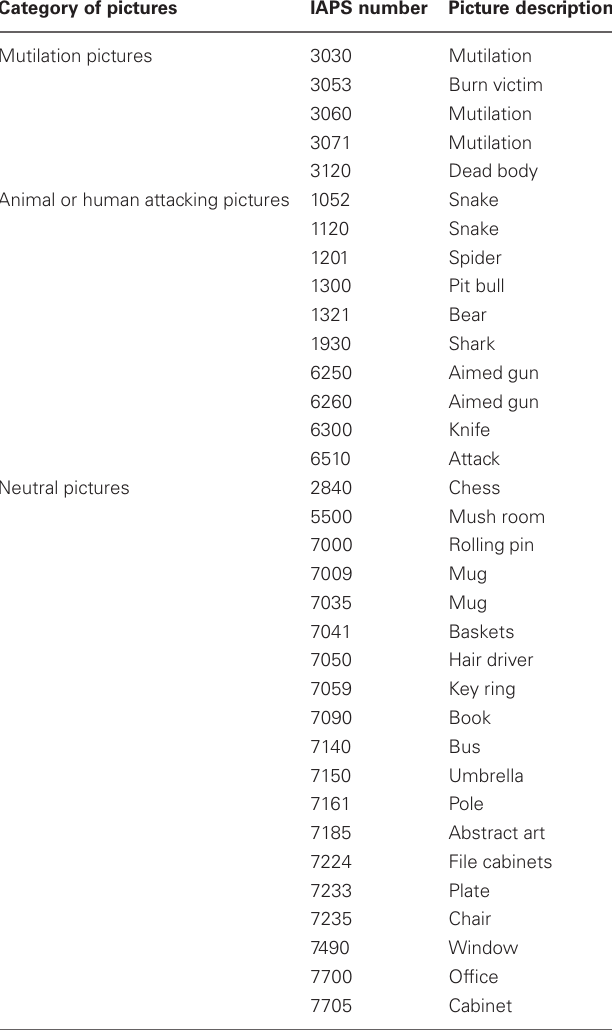
Table A1 | IAPS stimuli used in the current study. Category of